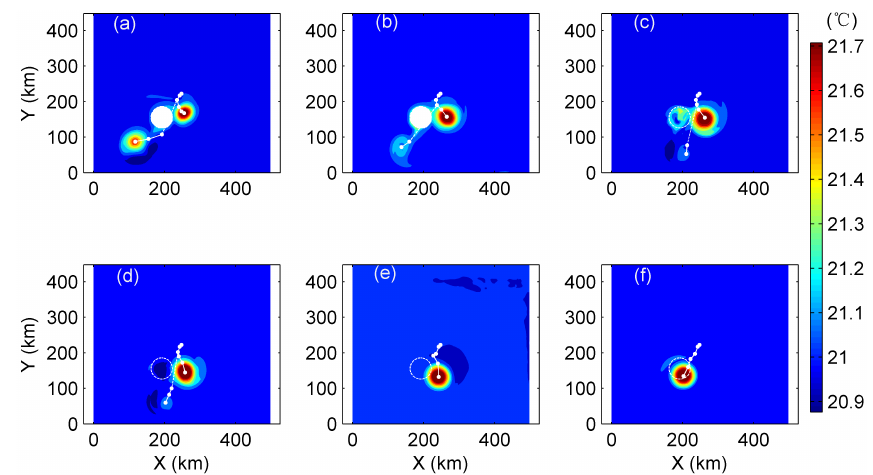
Figure 14. Eddy evolution in the case of the interaction with a seamount of 60km in diameter at 100m depth for different submergence depths (a) 10m, (b) 50m, (c) 100m, (d) 200m, (e) 500m and (f) 1000m. The temperature is shown in colours and the trajectory of the eddy centre is shown by white dotted